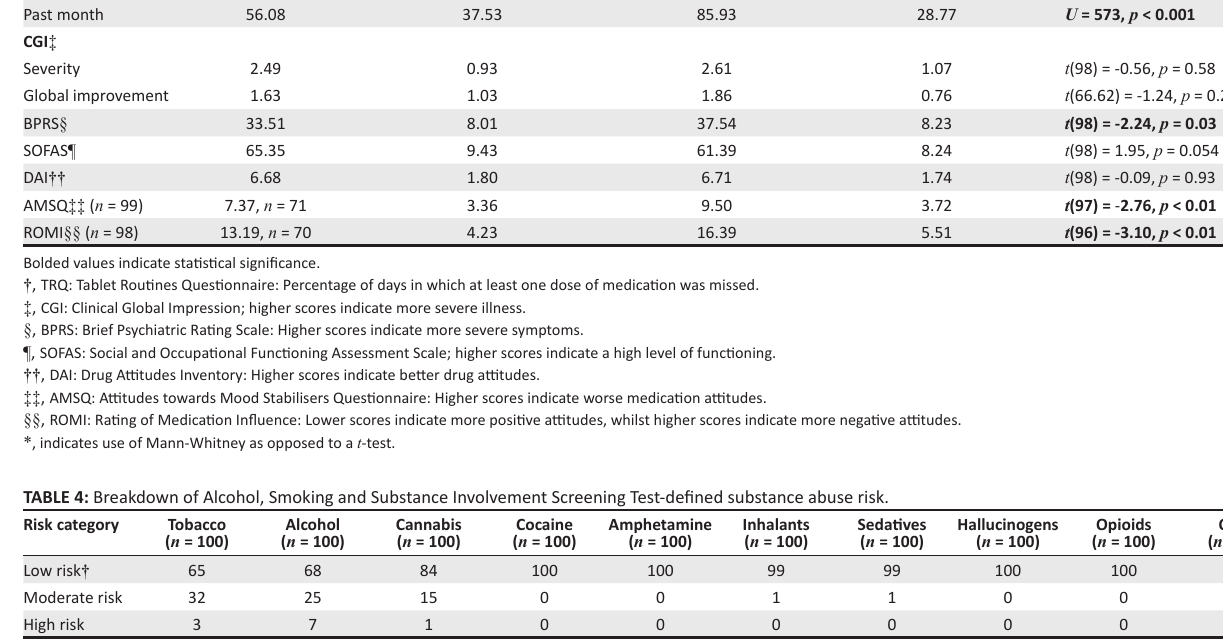
TABLE 5: Tobacco and cannabis use dichotimised by Alcohol Use Disorders Identification Test-defined low risk and moderate to high risk alcohol use groups.